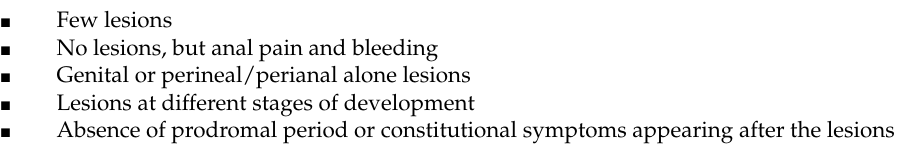
Table 7. Atypical features of the new monkeypox outbreak (adapted from [44]).